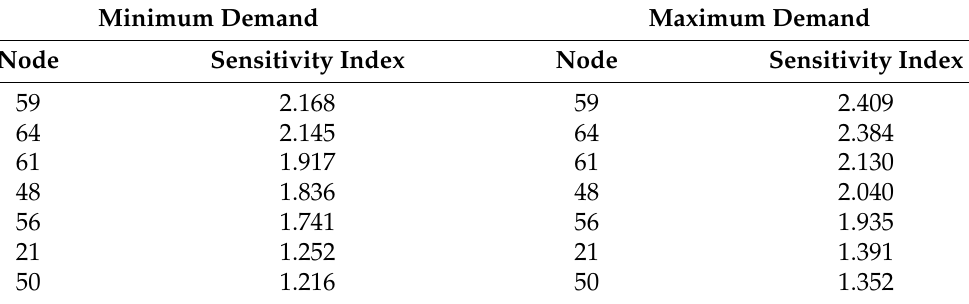
Table 1. Ranking of the nodes for minimum and maximum